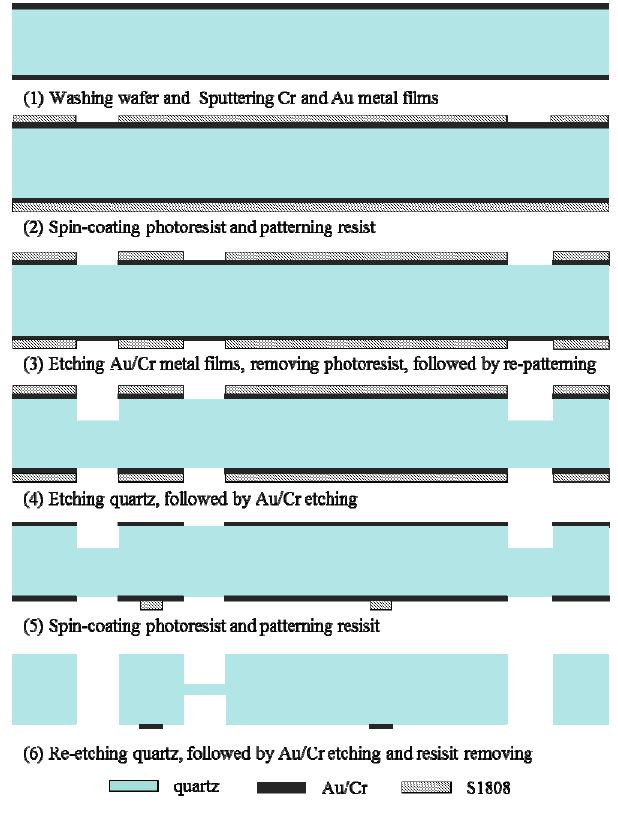
Figure 5. The fabrication process flow of base-proof mass